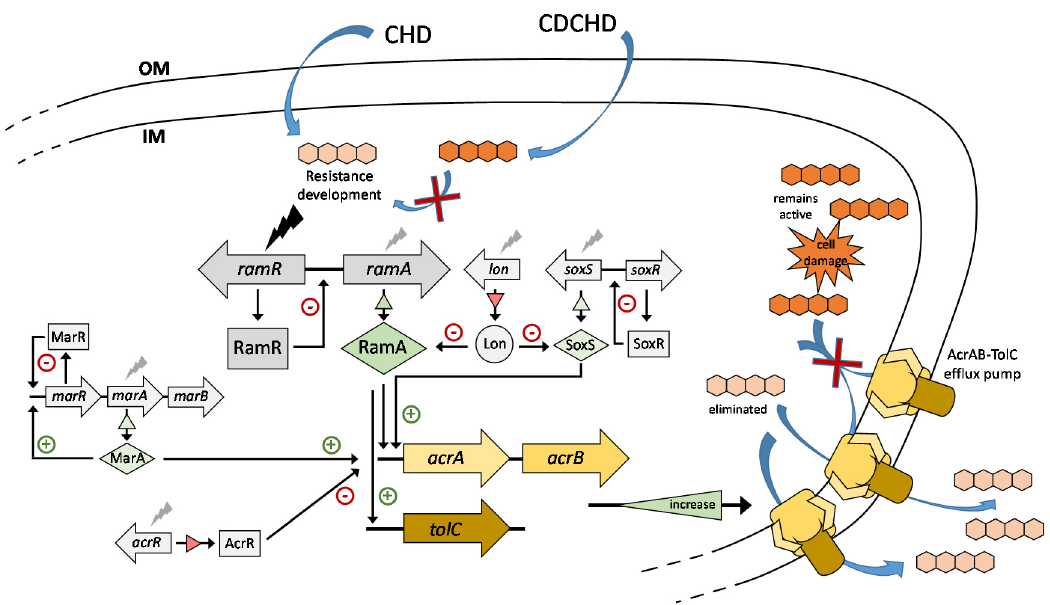
Figure 2. Current model of genes and regulatory cascades affected during resistance development against CHD in K. pneumoniae , leading to dysregulation of efflux mediated by AcrAB-TolC (pump schematically presented according to structural models [57,58]). In contrast to CHD, CDCHD does not lead to the development of resistant mutants and it is furthermore able to escape elimination through efflux (red crosses), hence retaining antimicrobial activity. Bolt-shaped arrows indicate resistance-associated effects either by direct mutation in the case of ramR (black bolt) or change of expression levels of various factors controlling acrAB-tolC expression (grey bolts). Gene products in grey rectangles and green diamonds represent transcriptional repressors and activators, respectively. Green and red triangles (associated with black arrows) represent increasing and decreasing amounts of gene products with direct influence on AcrAB-TolC production, respectively. The genes or operons a ff ected by CHD-mediated resistance include ram (resistance antibiotic multiple), sox (sulfur-oxidizing operon), mar (multiple antibiotic resistance), lon (encoding a serine protease), and acrAB-tolC (encoding the antibiotic e ffl ux pump) [36,41]. OM, outer membrane; IM, inner